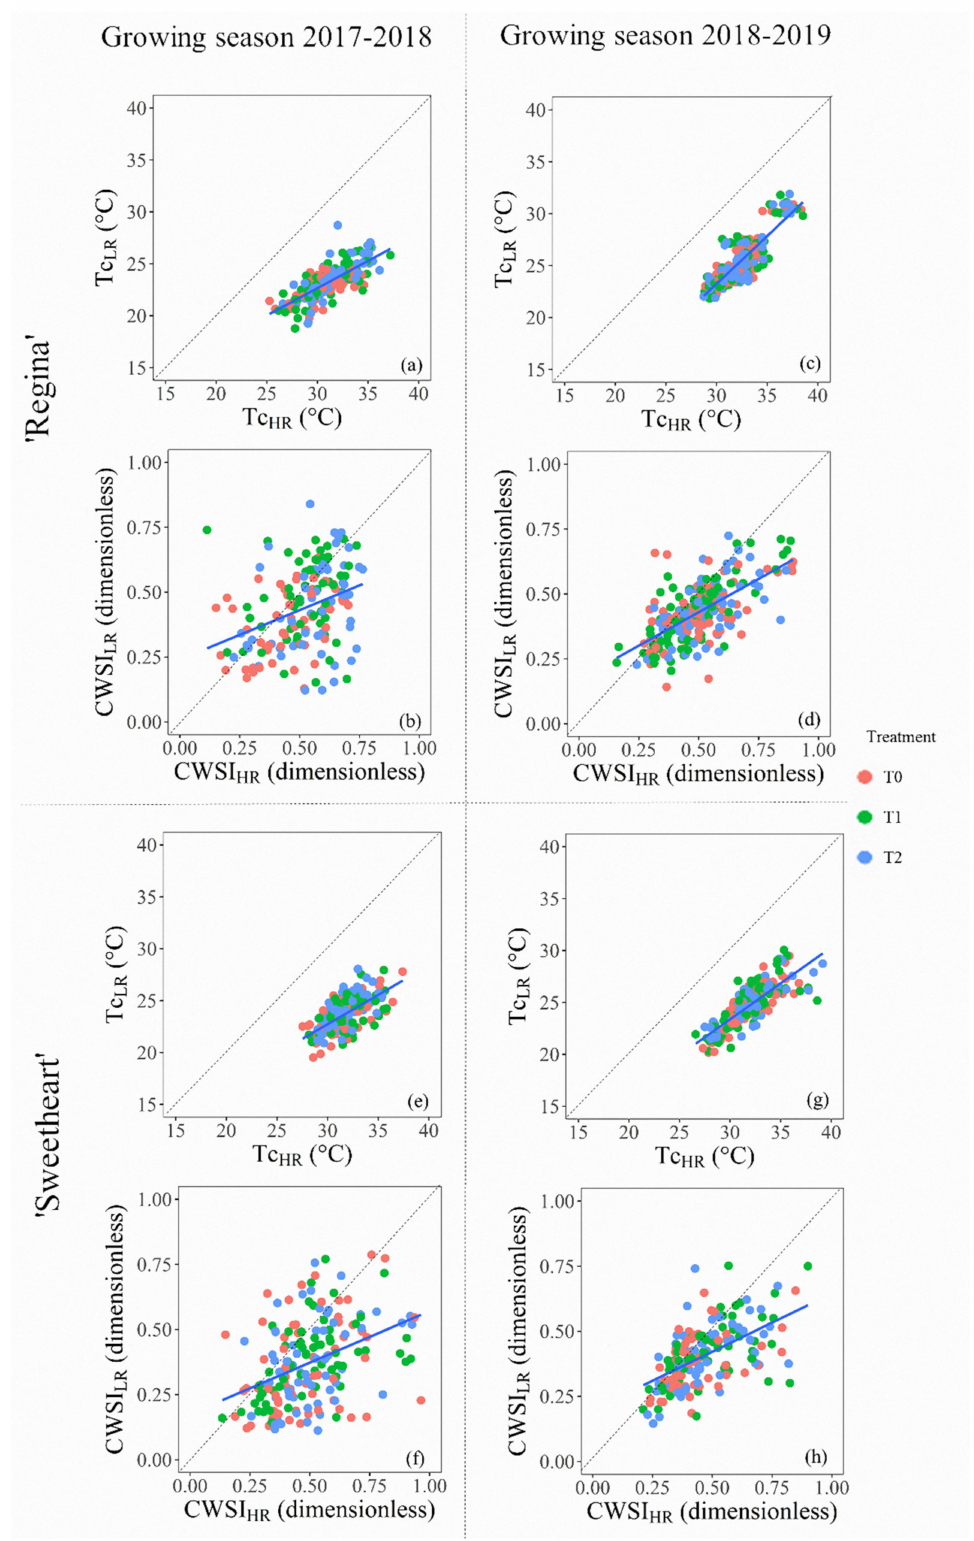
Figure7. Comparisonbetweendataobtainedfromthermalcamerasathigh(HR)andlow(LR)resolution for ‘Regina’ (superior: ( a – d )) and ‘Sweetheart’ (inferior: ( e – h )) cherry trees under three post-harvest irrigation treatments (control: T0 ( Ψ s ≥ − 1.0 MPa); low–medium water stress: T1 ( − 1.0 ≥ Ψ s ≥ − 1.5 MPa), and high (severe) water stress: T2 ( − 1.5 ≥ Ψ s ≥ − 2.0 MPa). Segmented lines at each figure depict the 1:1 line. Growing seasons 2017–2018 (left: ( a , b , e , f )) and 2018–2019 (right: ( c , d , g , h